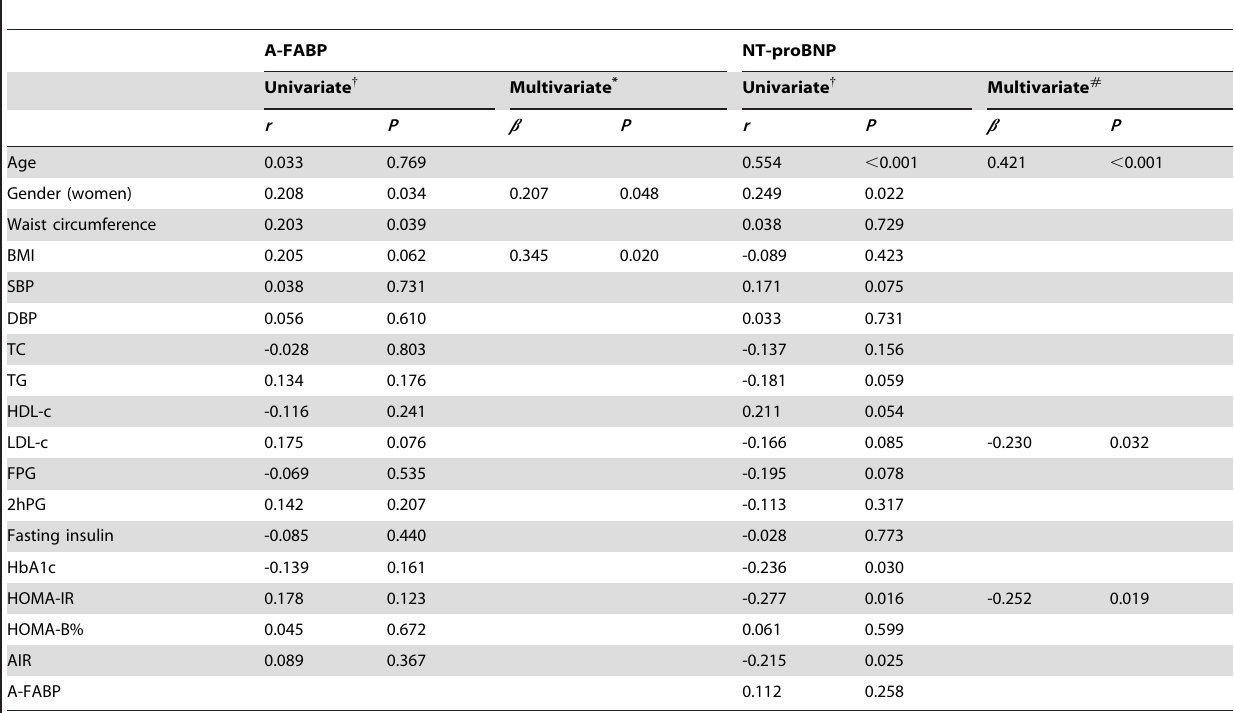
b , Standardized regression coefficients. { Pearson correlation analyses were performed. *A multiple stepwise regression analysis was performed. Variables included in the original model are age, gender, waist circumference, BMI, and LDL-c. # A multiple stepwise regression analysis was performed. Variables included in the original model are age, gender, SBP, TG, HDL-c, LDL-c, FPG, HbA1c, HOMA-IR, and